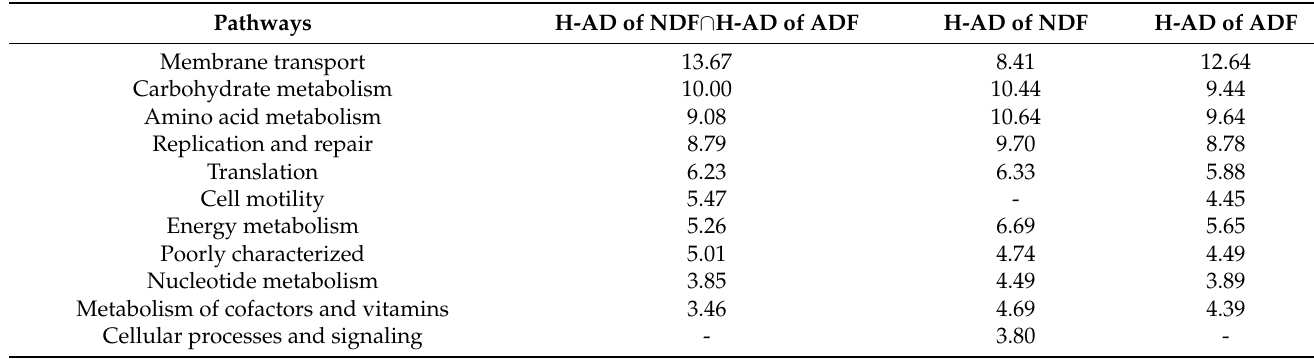
Table 4. The proportion of each group in the top 10 metabolic pathways abundance